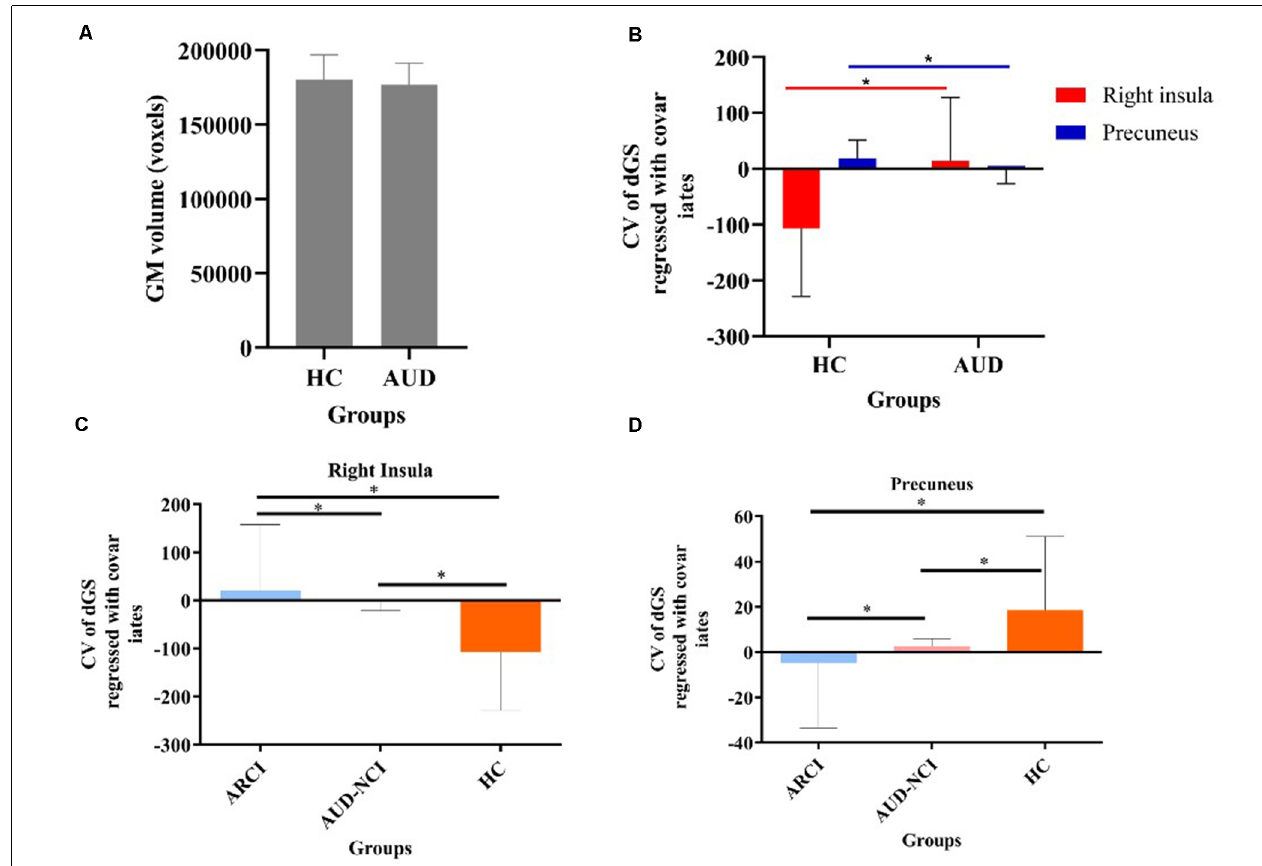
FIGURE 3 | The static and temporal dynamic changes of intrinsic brain activity in control and AUD groups. (A) Gray matter (GM) volume in voxels between HC and AUD group ( p > 0.05). (B) Dynamic global signal topography (GST; right insula and precuneus) in HC and AUD groups ( p < 0.05). (C) Dynamic GST in the right insula in different groups ( p < 0.05). (D) Dynamic GST in precuneus in different groups. * p < 0.05.